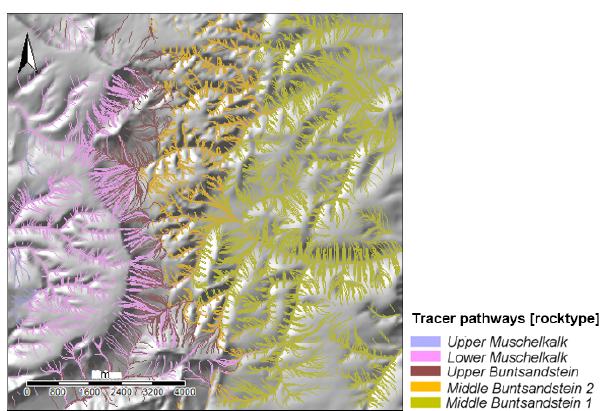
Figure 6. Transport pathways in Ebergötzen of the virtual tracer particles from the location of their release from the rock via weath- ering and erosion to the place where the transport